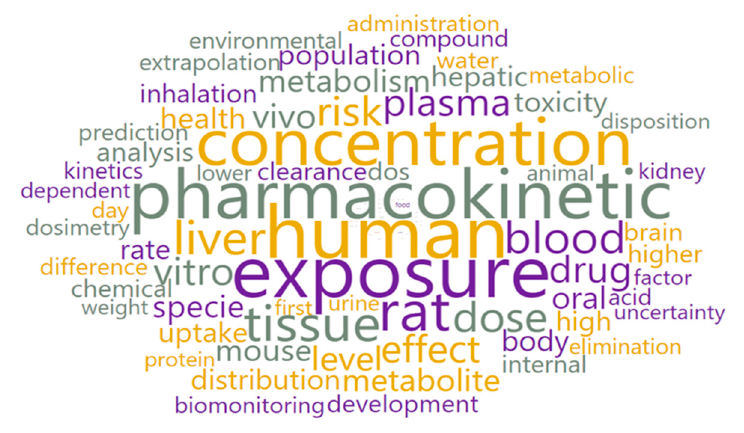
Figure 7. Word cloud for topic 1.